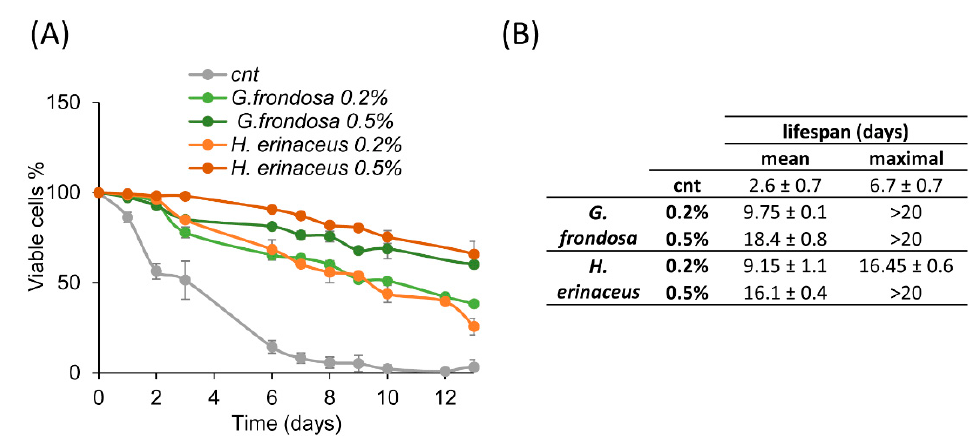
Figure 2. Fungal extracts extend yeast lifespan. ( A ) CLS of wt cells grown in minimal medium containing 2% glucose in the absence (cnt) or presence of 0.2% or 0.5% extract of G. frondosa or H. erinaceus . ( B ) Mean and maximal lifespan of wt cells grown in the presence of the indicated fungal extracts.